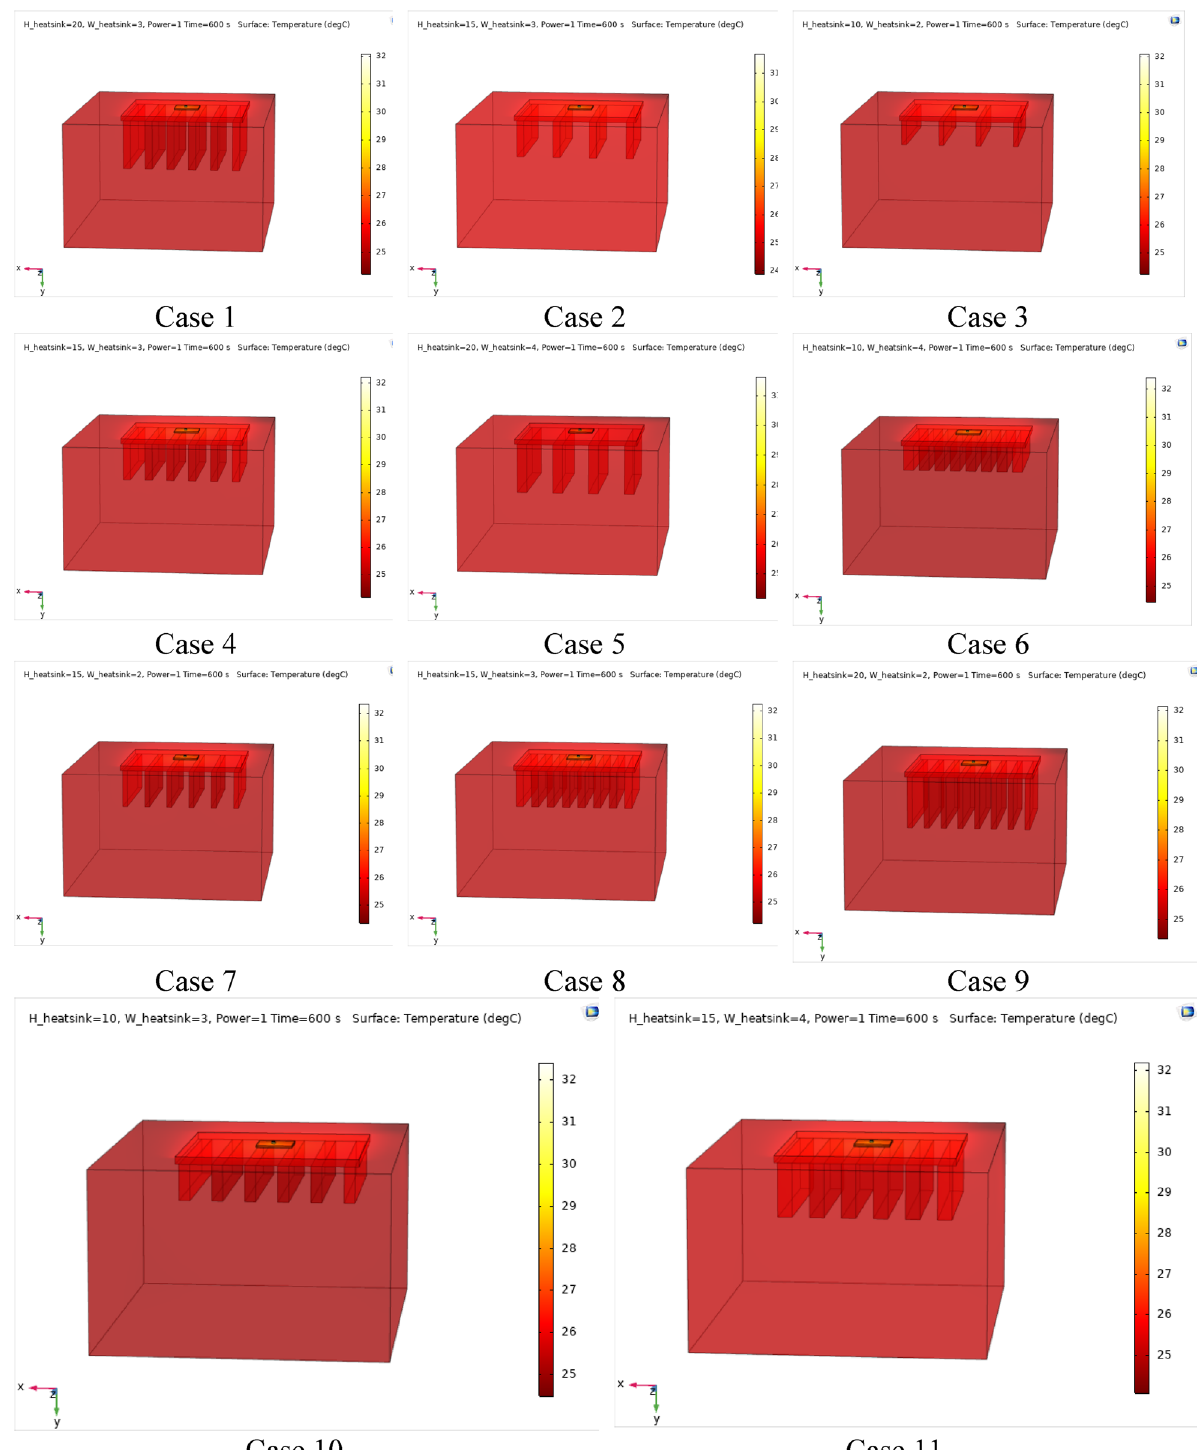
Figure 4. Temperature contours for the finned micro-channel of different geometries (11 Cases) (COMSOL Multiphysics 5.6, https:// www. comsol.